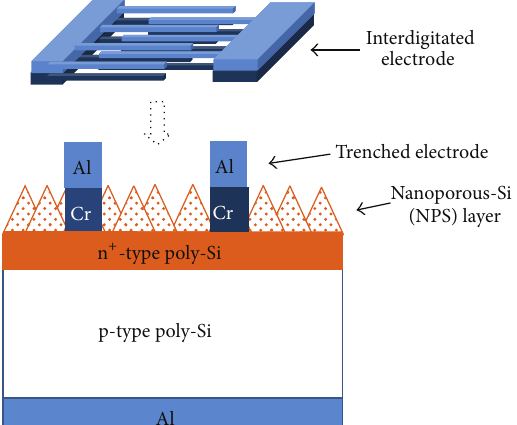
Figure 1: The schematic structure of a NPS/poly-Si solar cell with trenched electrodes. Interdigitated Cr/Al electrodes were also shown above the